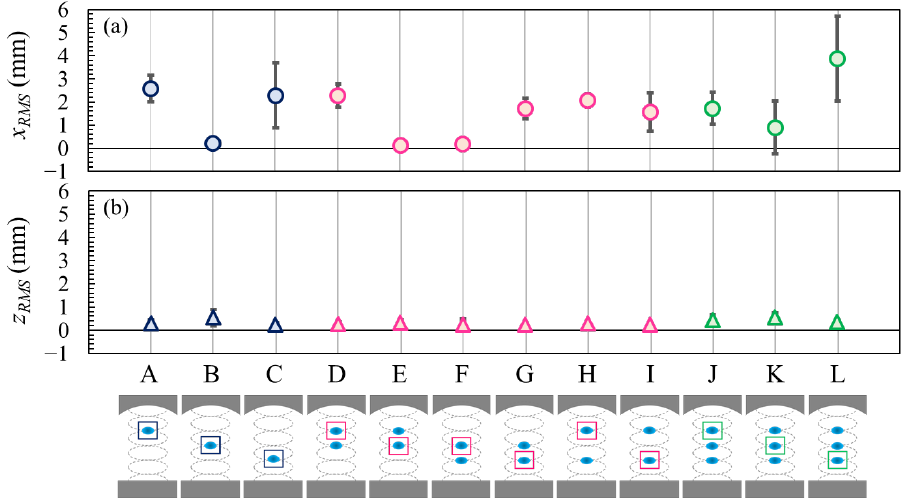
Figure 4. RMS displacement of the levitated droplets in the ( a ) horizontal and ( b ) vertical directions. The average values were used for each plot, and the error bars represent the standard deviations of the three experiments. The solid line represents x rms = z rms = 0.